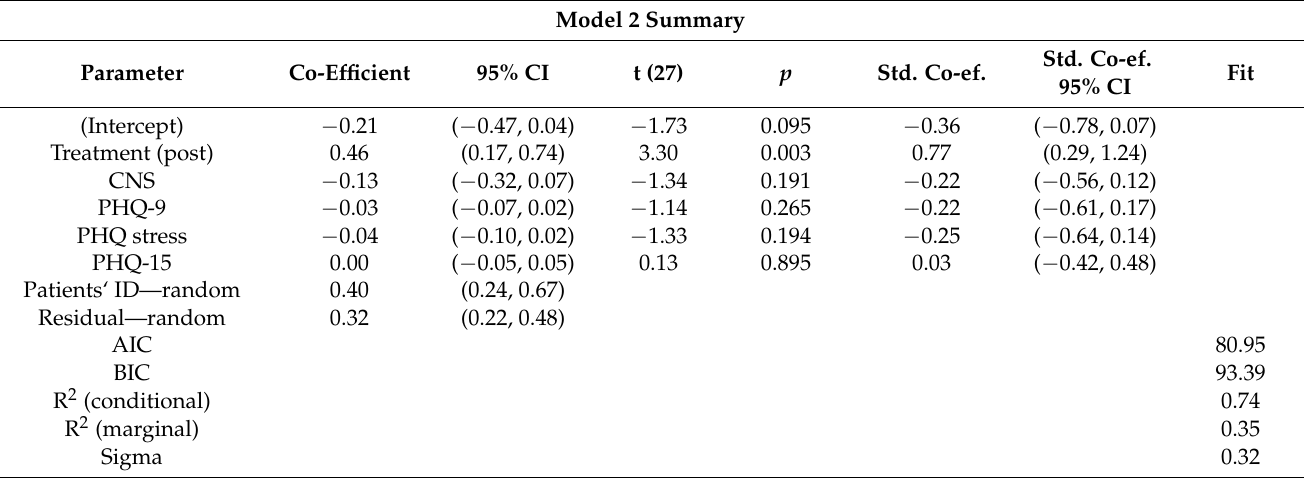
Table 3. Linear Mixed Effects Analysis. Model 2 predicting mental well-being (WOHL) by Treatment, Connectedness to Nature Scale (CNS), and PHQ-D subscales (PHQ-9, PHQ-15, and stress).